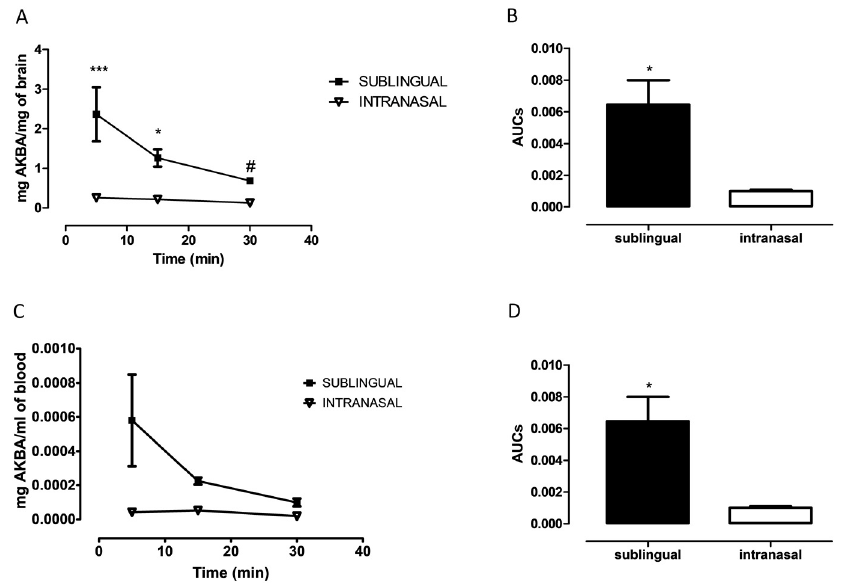
Figure 2. Cerebral AKBA quantification after sublingual or intranasal administration. ( A ) Cerebral AKBA levels (mg AKBA/mg of brain) at 5, 15, and 30 min after sublingual (black square, n = 4, 15 n = 4, 30 n = 5), or intranasal (reverse empty triangle, 5 n = 5, 15 n = 5, 30 n = 5) administration. ( B ) Cerebral AUCs of sublingual (black bar, n = 5), and intranasal (empty bar, n = 5) administration. ( C ) Plasmatic AKBA levels (mg AKBA/mg of brain) at 5, 15, and 30 min after sublingual (black square, n = 4, 15 n = 4, 30 n = 5), or intranasal (reverse empty triangle, 5 n = 5, 15 n = 5, 30 n = 5) administration. ( D ) Plasmatic AUCs of sublingual (black bar, n = 5), and intranasal (empty bar, n = 5) administration. Two-way ANOVA followed by Bonferroni multiple comparisons test * p < 0.05 sublingual vs. intranasal at 5 min; *** p < 0.001 sublingual vs. intranasal. One-way ANOVA followed by Tukey’s multiple comparisons test, # p < 0.05 5 vs. 30 min for sublingual.